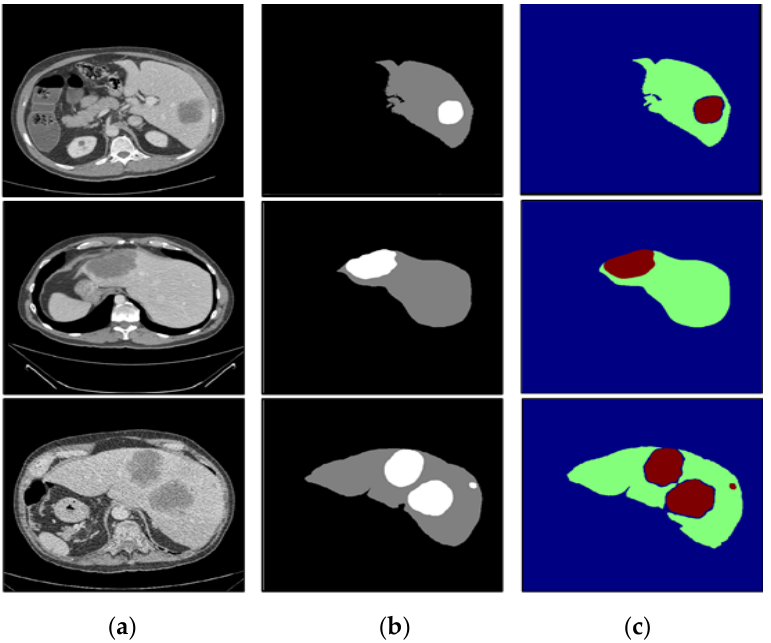
Figure 11. The segmentation results of our algorithm for large liver tumors: ( a ) CT original images; ( b ) the real segmentation results; ( c ) our segmentation results.